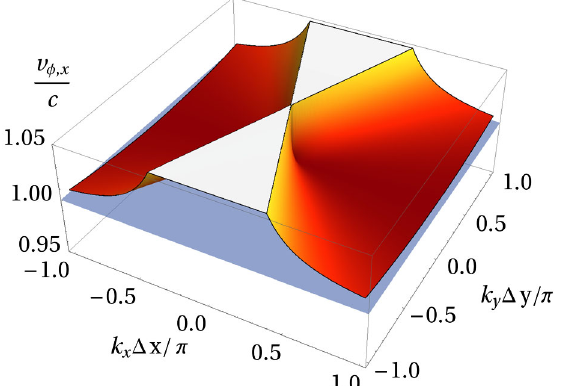
FIG. 5. Spatial Fourier transform of the field E Fig. 2. The two red spots correspond to the laser field ( k (cid:1) x=(cid:7) ¼ (cid:6) 0 : 08 ). The structures observed near k (cid:6) k laser FIG. 3. Physical phase velocity along x ( v , as deduced from correspond to the fields of the bubble (their broad extent along (cid:5);x ! 2 ¼ c 2 ~k 2 ) as a function of k and k for electromagnetic modes k in Fourier space corresponds to the sharp edges of the bubble in x y y ¼ 0 ). The blue horizontal plane propagating in the x - y plane ( k real space). The dashed line materializes the position of the modes z ¼ (cid:6)c with (cid:6) ¼ 1 (cid:1) 9 (cid:3) 10 (cid:1) 6 (which is corresponds to v satisfying Eq. (3) (with (cid:6) ¼ 1 – 9 (cid:3) 10 (cid:1) 6 ) and thus corresponds to (cid:5);x representative of particles having an energy of 120 MeV). the intersection of the two theoretical surfaces of Fig.